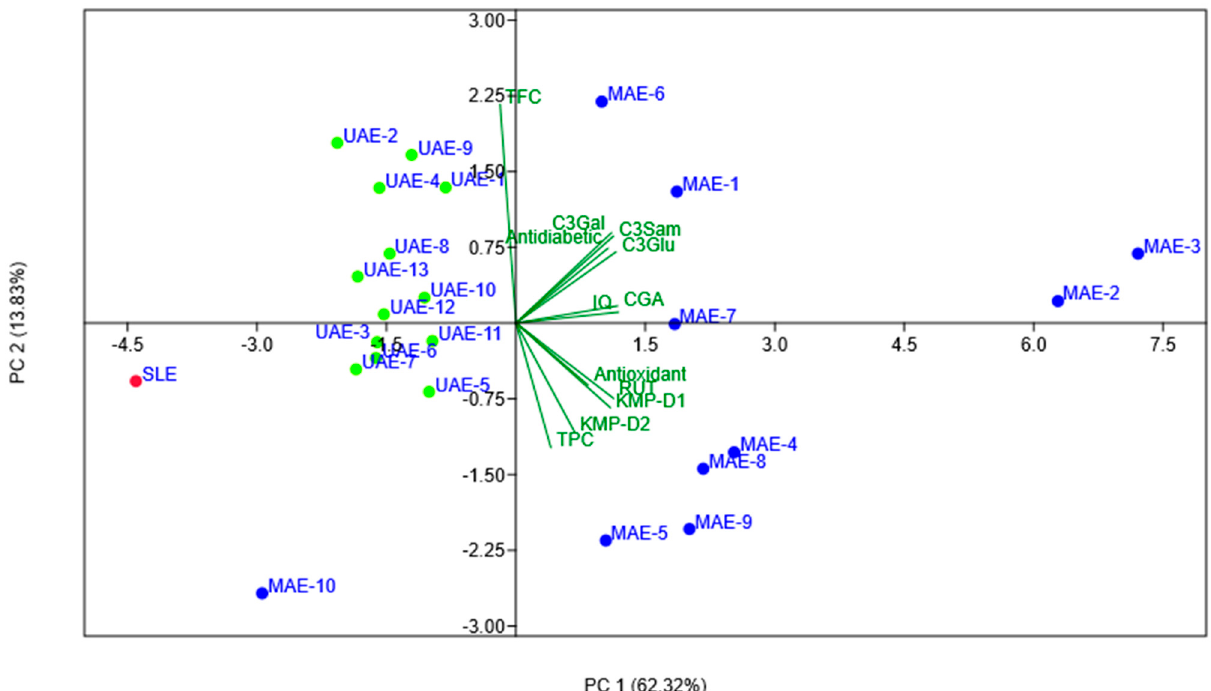
Figure 1. PC1 vs. PC2 biplot of obtained black elderberry press-cake extracts represented as scores and the investigated characteristics as loadings. SLE—red, MAE—blue, UAE—green. and the investigated characteristics as loadings. SLE—red, MAE—blue,